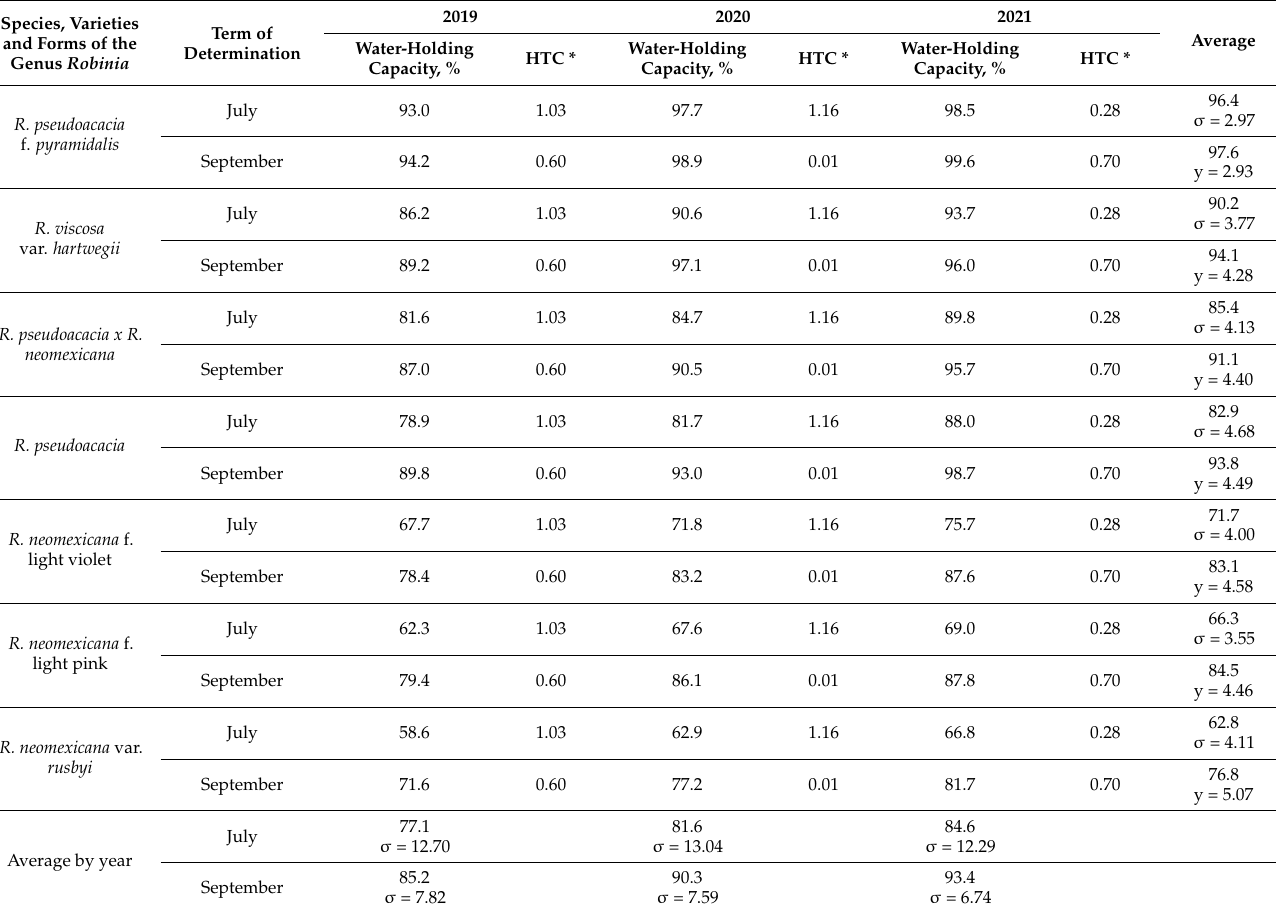
Table 3. The water-retaining ability of the leaf tissues of representatives of the genus Robinia , ex- pressed in % ratio of lost water to the initial content after exposure for 24 h.